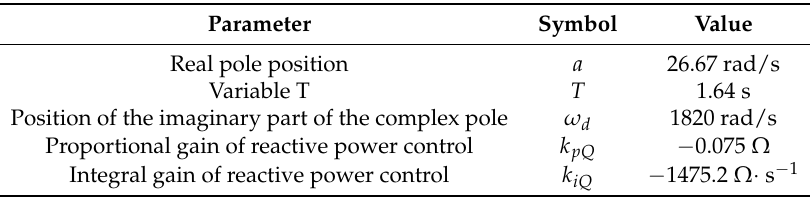
Table 3. Gains of the reactive power controller for the prototype